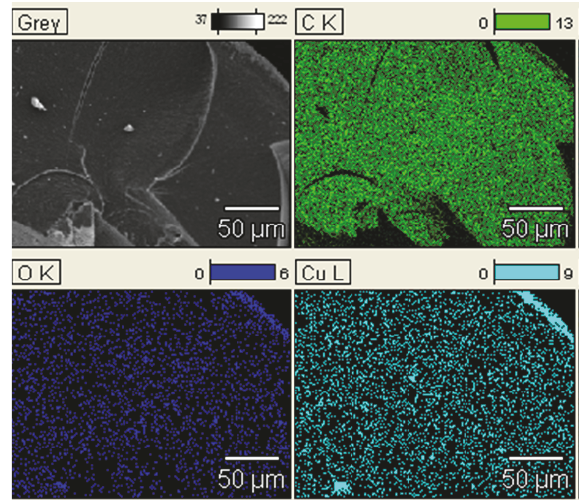
Figure 4: SEM image with EDS mapping analysis of distribution of copper, carbon, and oxygen on the cross section of the polymer bead impregnated with